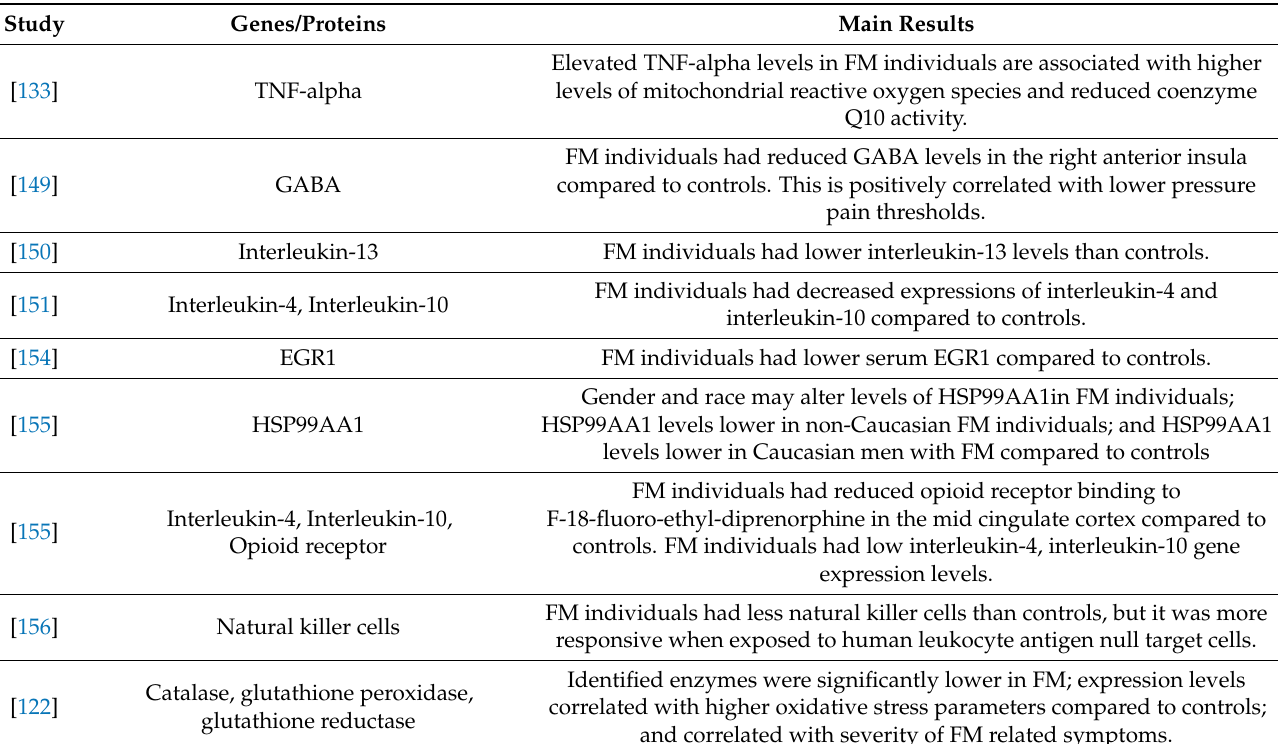
Table 7. Associations of downregulated genes/proteins and